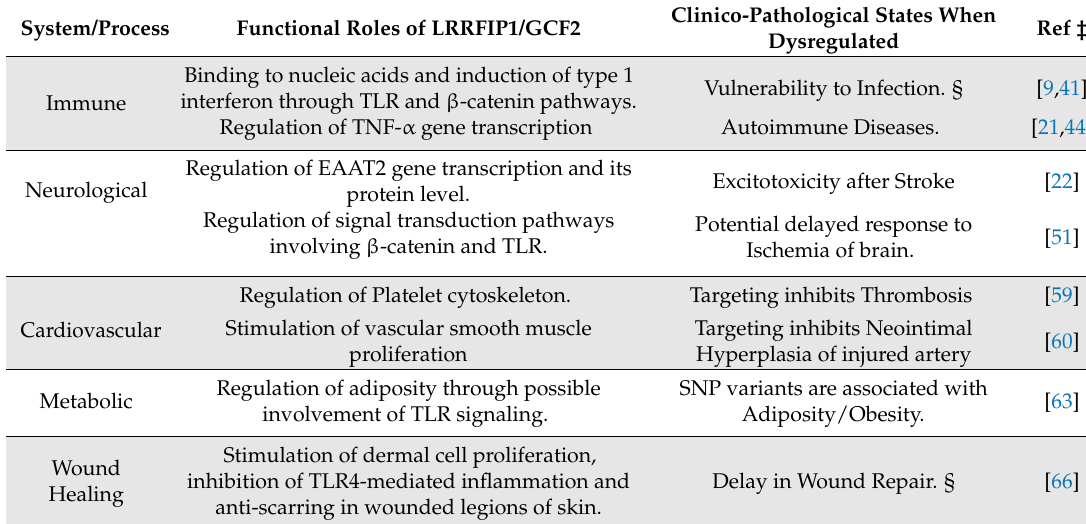
Table 1. LRRFIP1/GCF2 and Human Diseases.